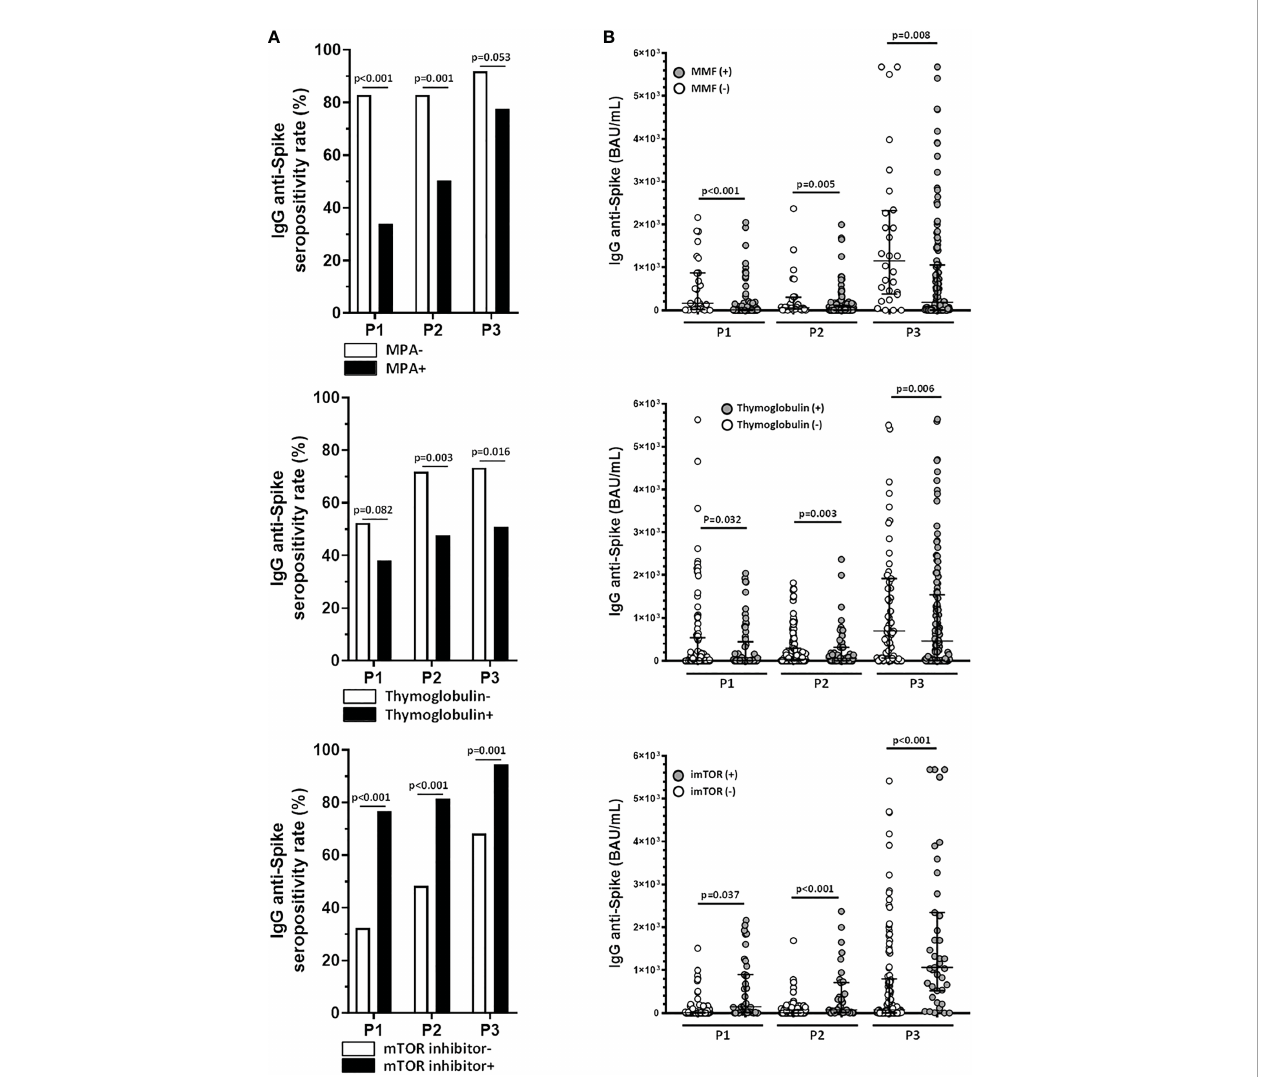
FIGURE 4 Treatment with mycophenolate and thymoglobulin reduces the ef fi cacy of the humoral response in kidney transplant recipients, whereas therapy with mTOR inhibitors reverses the negative effect of immunosuppressive therapy in these patients. (A) Humoral response rates comparing mycophenolate (MPA), thymoglobulin and mTOR inhibitor therapies. (B) Levels of anti-Spike IgG antibodies comparing therapies with mycophenolate (MPA), thymoglobulin and mTOR inhibitors. Patients under MPA had lower IgG anti-spike titers than those without it in all points (P1: 2.6 (0.1-19.9) vs 149.4 (12.4-966.3) BAU/mL, p<0.001; P2: 7.1 (0.7-109.9) vs 50.1 (9.5-300.5) BAU/mL, p=0.005; P3: 104.2 (5.3-1051.5) vs 737.5 (213.1-2183.5) BAU/mL, p=0.008). The same behavior was performed in KTR who received thymoglobulin (P1: 4.5 (0.1-135.5) vs 13.8 (0.7-759.4) BAU/mL, p=0.032, P2: 5.8 (0.6- 68.0) vs 46.9 (4.3-317.2) BAU/mL, p=0.003, P3: 56.7 (2.3-877.8) vs 1378.1 (53.0-1919.3) BAU/mL, p=0.006). In patients treated with mTORi, antibody titers were higher vs non-treated (P1: 162.7 (9.2-1093.4) vs 2.6 (0.1-20.3) BAU/mL, p<0.001; P2: 145.6 (12.6-709.4) vs 6.0 (0.7-70.4) BAU/mL, p<0.001; P3: 1036.2 (366.4-2270.0) vs 70.3 (3.4-761.7) BAU/mL, p<0.001). Graphs include data for each sampling after vaccination and p-values for each Mann- Whitney U